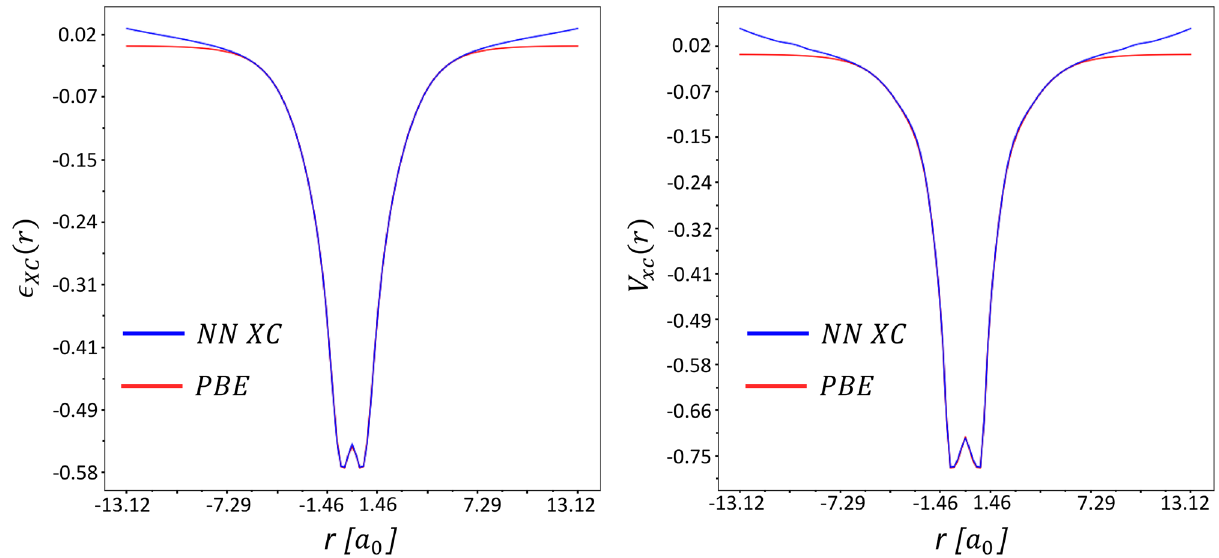
Figure 7. Slices of ε xc and V xc along the line connecting the atoms of a hydrogen molecule. Blue lines represent values predicted by our NN, red lines—values obtained by Octopus (where V xc is correct functional derivative).